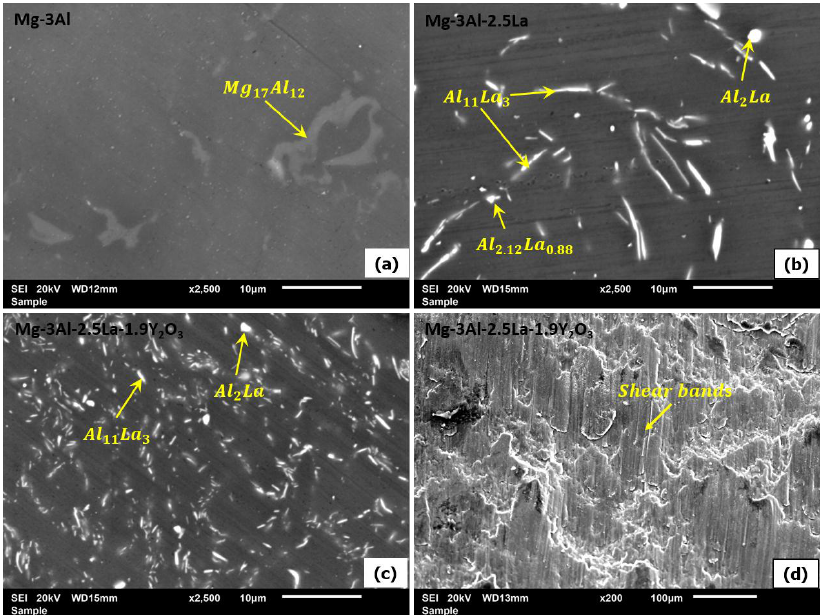
Figure 3. SEM micrographs of ( a ) Mg–3Al, ( b ) Mg–3Al–2.5La, and ( c ) Mg–3Al–2.5La–1.9Y 2 O 3 alloys; ( d ) compressive fractograph of Mg–3Al–2.5La–1.9Y 2 O 3